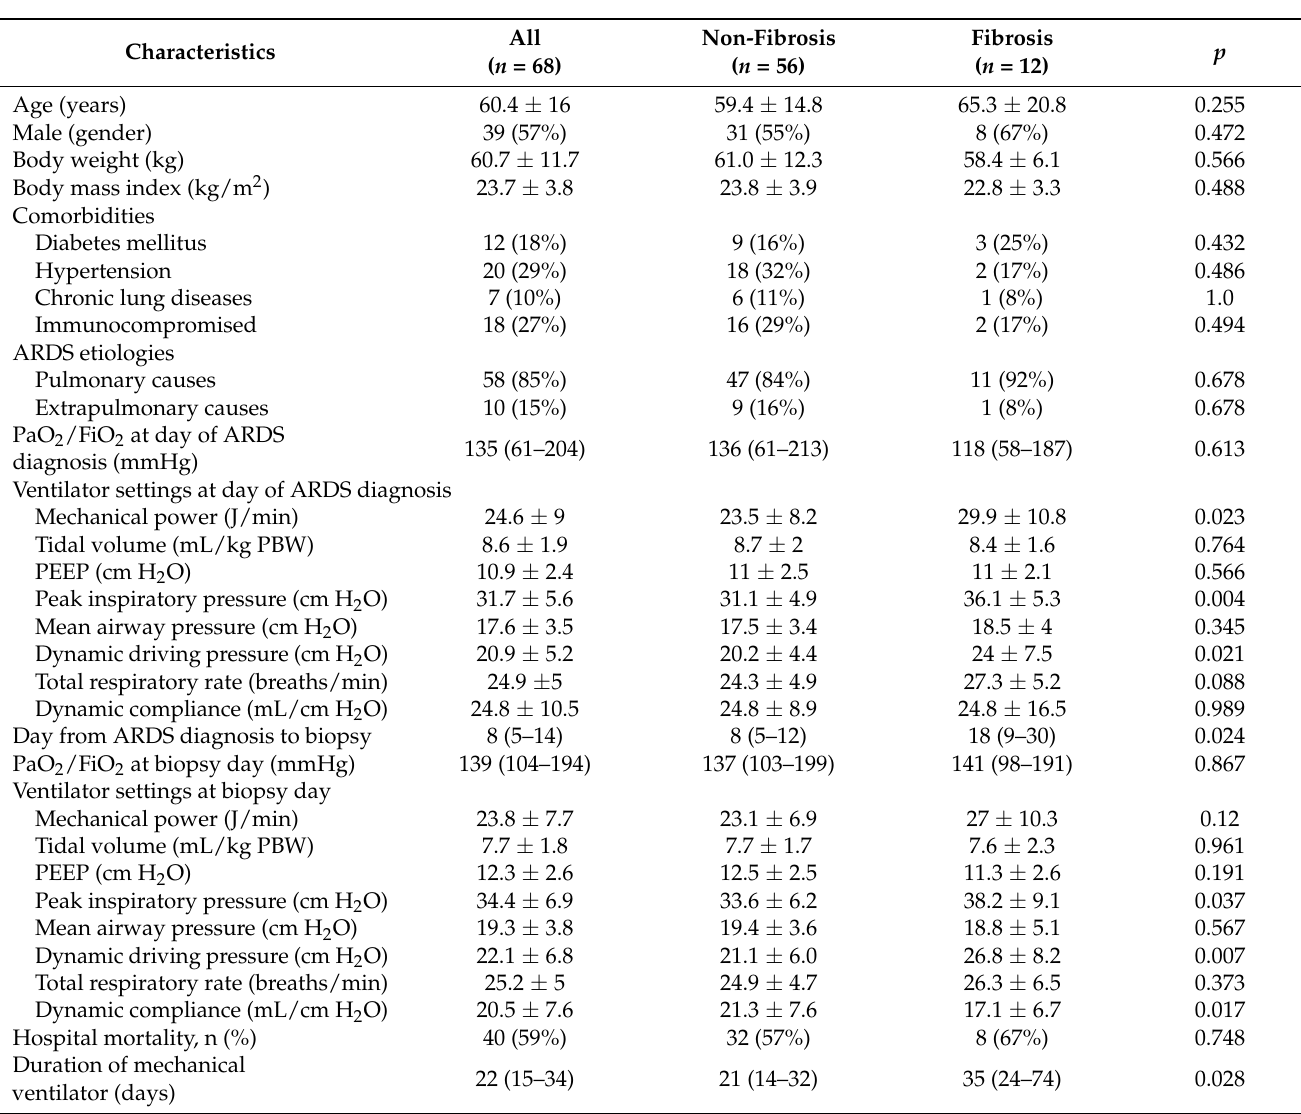
Table 1. Background characteristics and clinical variables: non-fibrosis and fibrosis on histologi- cal